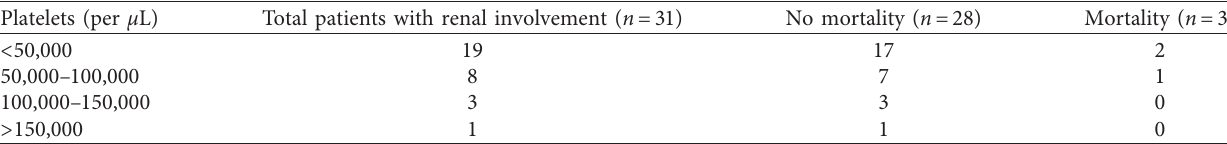
Table 6: Outcome of renal involvement associated with platelet count.